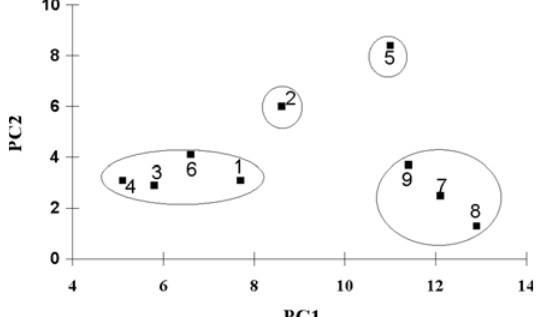
Figure 2. Score dispersion of pure stands, mixed stands, secondary forest and primary forest, derived from the nutrient concentration (N, P, K, Ca and Mg) of leaves, branches, bark and stemwood, when related to the principal components (PC1 and PC2) and to the grouping by Tocher’s Method, based on standardized Euclidian average distance. 1: P. angustiflora ,